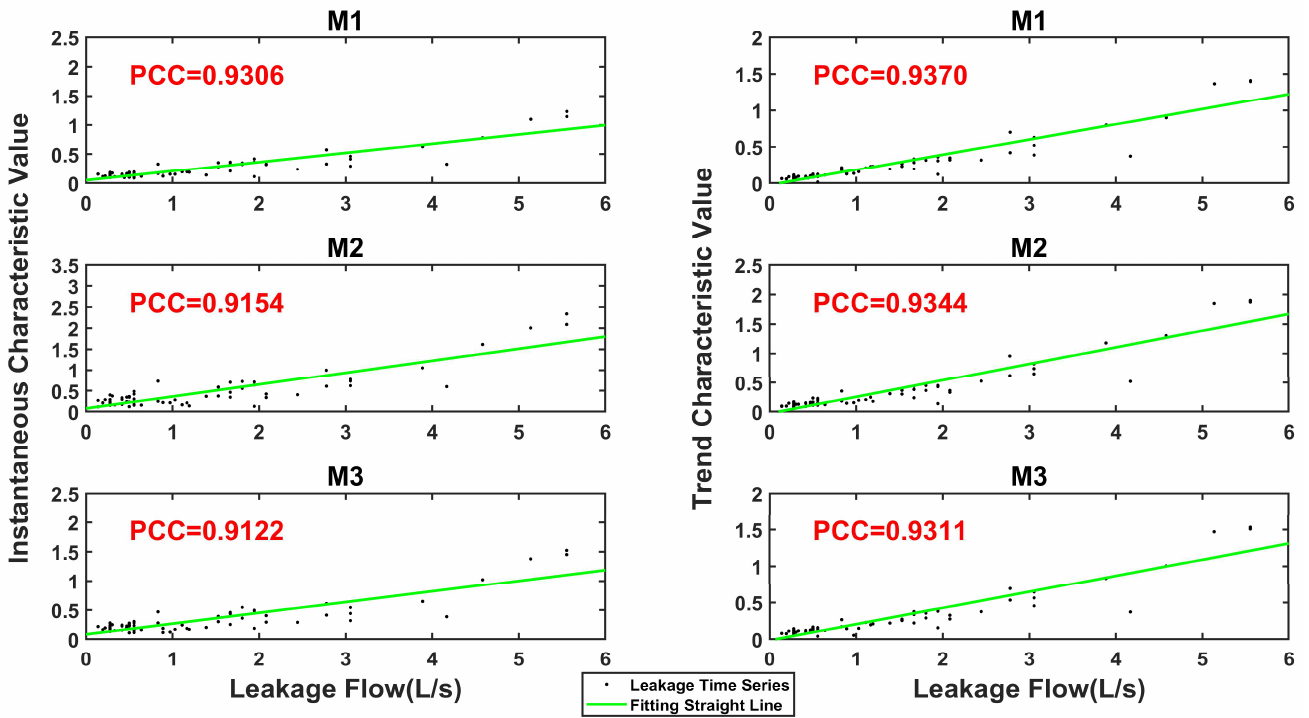
Figure 8. Relationships between characteristic values of leakage events and leakage flow in the water-consumption time series data set.